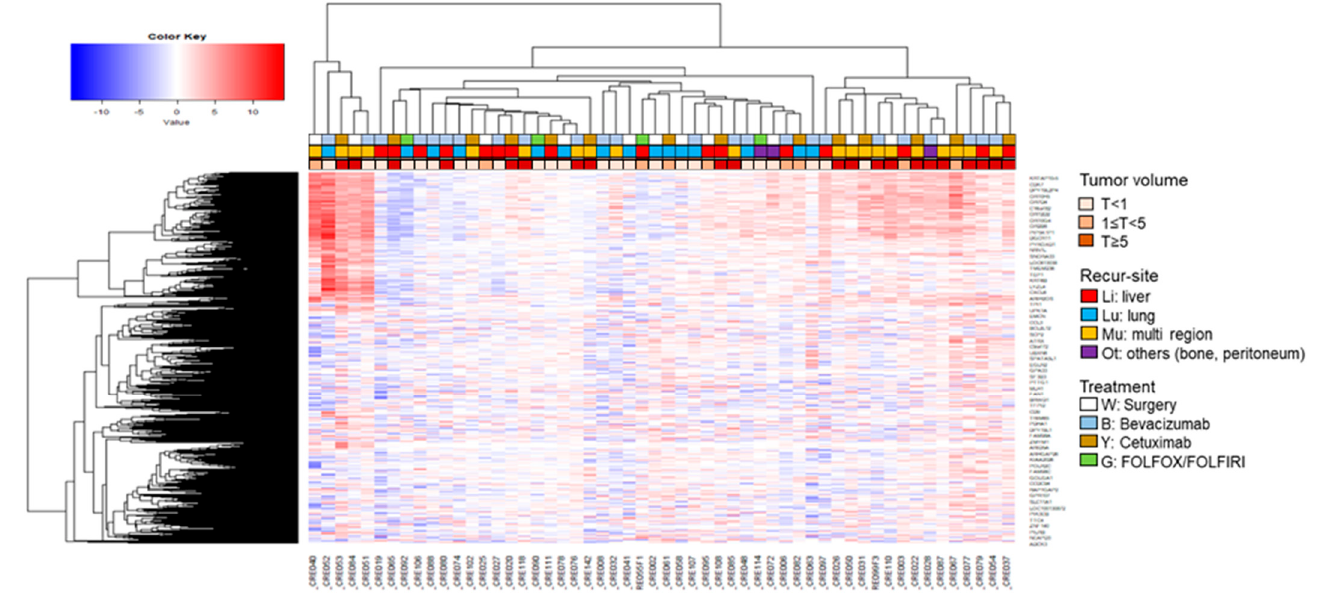
Figure 2. Hierarchical clustering of exosomal RNA expression profiles.